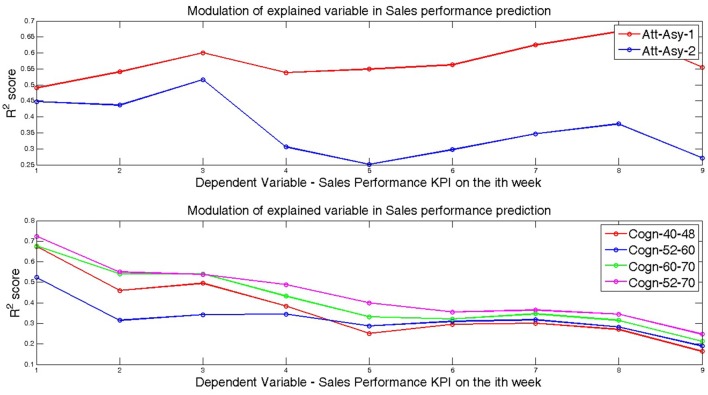
Shows the modulation of the R2 score for the Att-Asy-1, Att-Asy-2 models (top panel) and Cogn-40-48, Cogn-52-60, Cogn-60-70, Cogn-52-70 models (bottom panel) for the nine dependent variables (i.e., sales performance key performance indicator (KPI) on the movie premiere and the eight following weekends). The model abbreviations are as follows: Att-Asy-1: Attentional asynchrony metric during the first viewing is used as the independent variable; Cogn-52-70: Cognitive-congruency metric calculated in the frequency range between 52 Hz and 70 Hz is used as the predictor variable; Att+Cogn: The combined predictor model where both the Cognitive-congruency metric calculated on the frequency range 52–70 Hz and the Attentional-asynchrony metric (calculated on measurements from the first viewing) are used as predictor variables. The numerical values of R2 and Standard Error (SE) scores calculated using the bootstrap method are shown in Table 1.